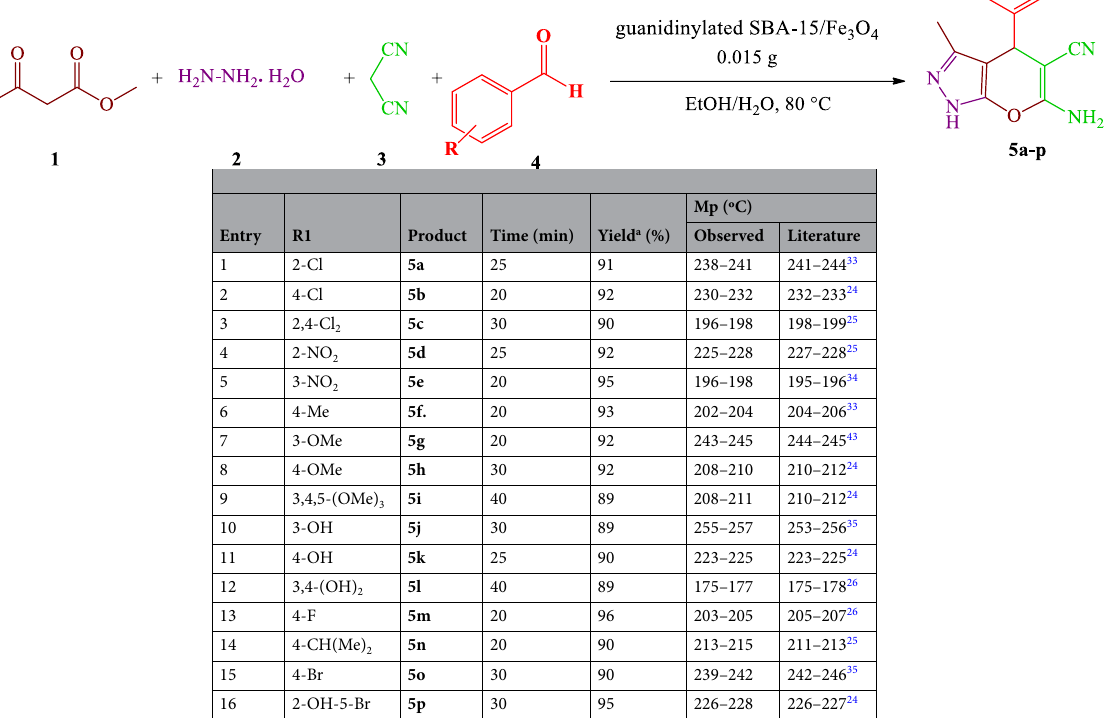
Table 3. The synthesis of dihydropyrano[2,3-c] pyrazole derivatives in optimized condition using the guanidinylated SBA-15/Fe 3 O 4 . a The yields relate to the isolated